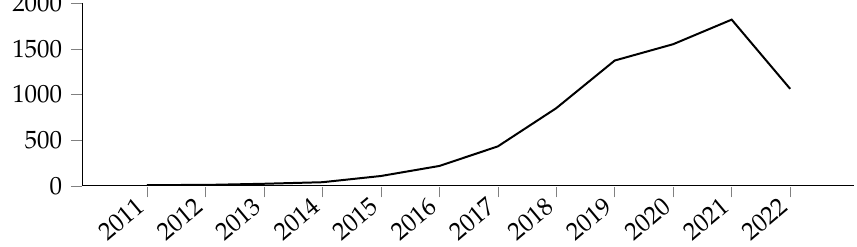
Figure 1. Publications for total results about pooling for CNNs in